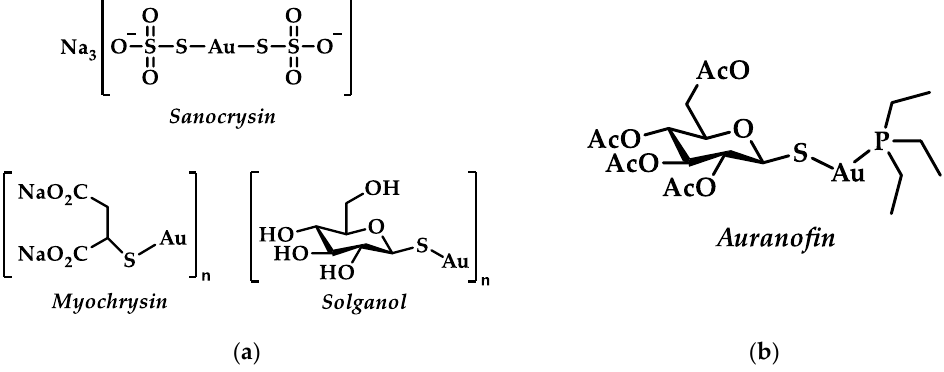
Figure 1. ( a ) Au(I) complexes used for the treatment of RA; ( b ) Chemical structure of orally-active drug, auranofin.